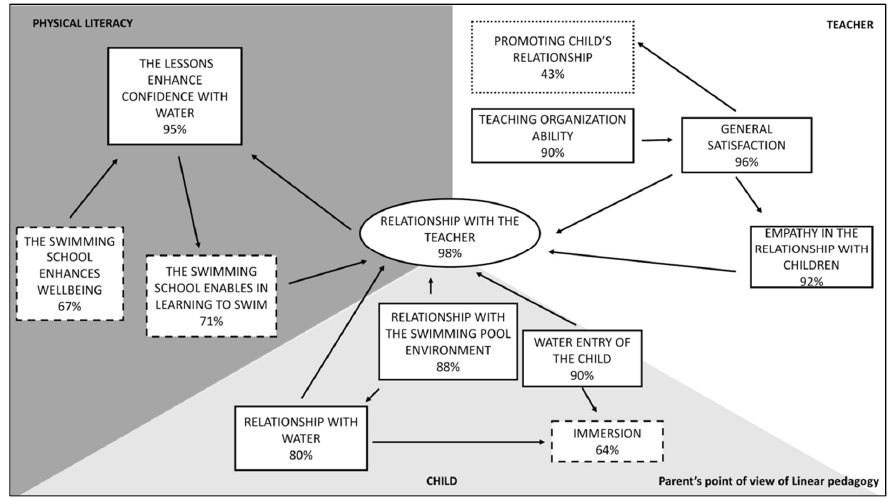
Figure 2. Diagram related to the parents’ perception of LI group as revealed by the administered questionnaire.